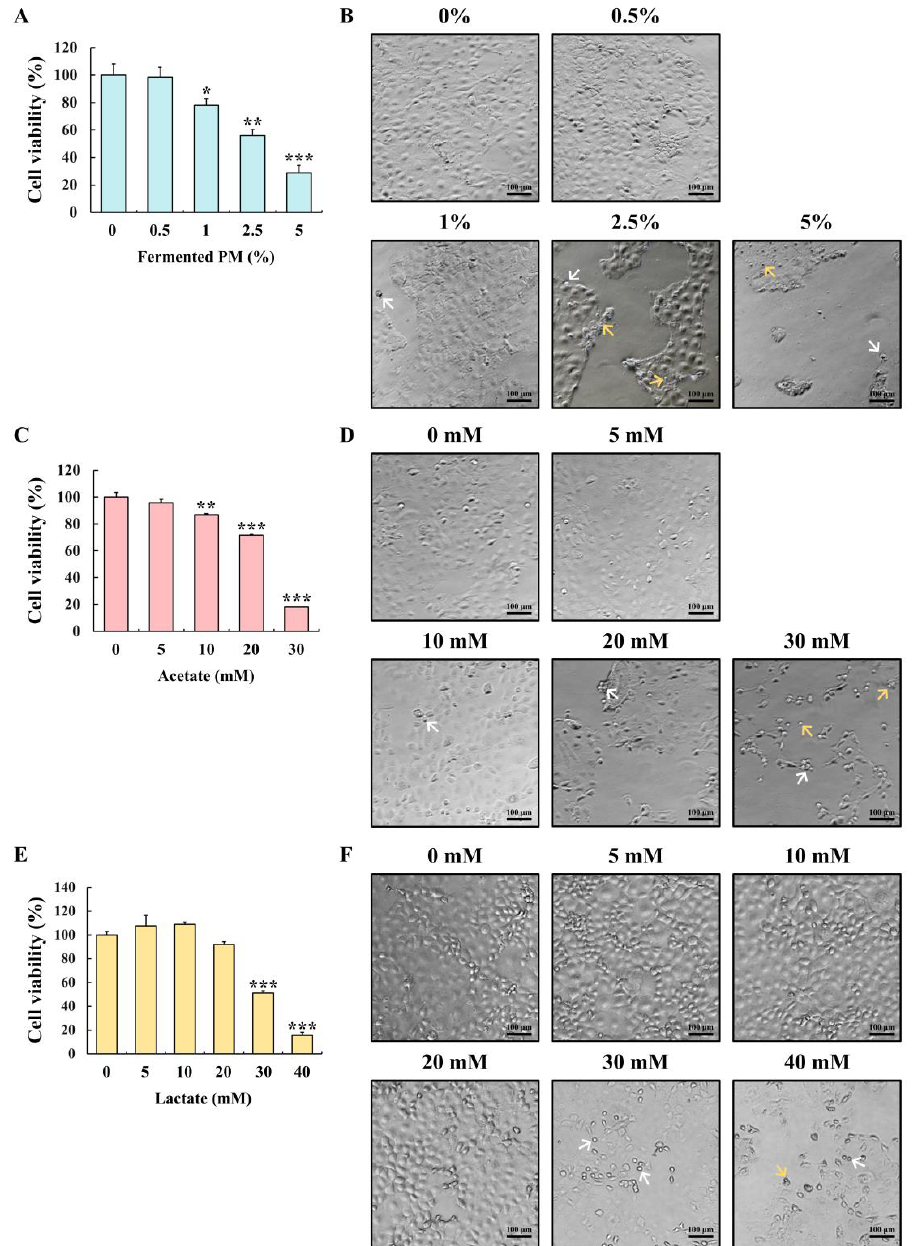
Figure 4. Effects of fermented PM, acetate, and lactate on cell viability and morphology. The cell via- bility treated with ( A ) fermented PM, ( C ) acetate, and ( E ) lactate in Caco-2 cells. The cell morphology treated with ( B ) fermented PM, ( D ) acetate, and ( F ) lactate in Caco-2 cells. The magnification of the cell morphology image was 100 × . Scale bar = 100 µ m. White arrows indicate rounded cells. Yellow arrows indicate rounded and shrunk cells. The cells were treated with fermented PM (0, 0.5, 1, 2.5, and 5%), acetate (0, 5, 10, 20, and 30 mM), and lactate (0, 5, 10, 20, 30, and 40 mM) for 48 h ( n = 3 wells per groups). Results are expressed as mean ± standard error ( n = 3). * ( p < 0.05), ** ( p < 0.01), and *** ( p < 0.001) indicate significant differences compared with the control (0% and 0